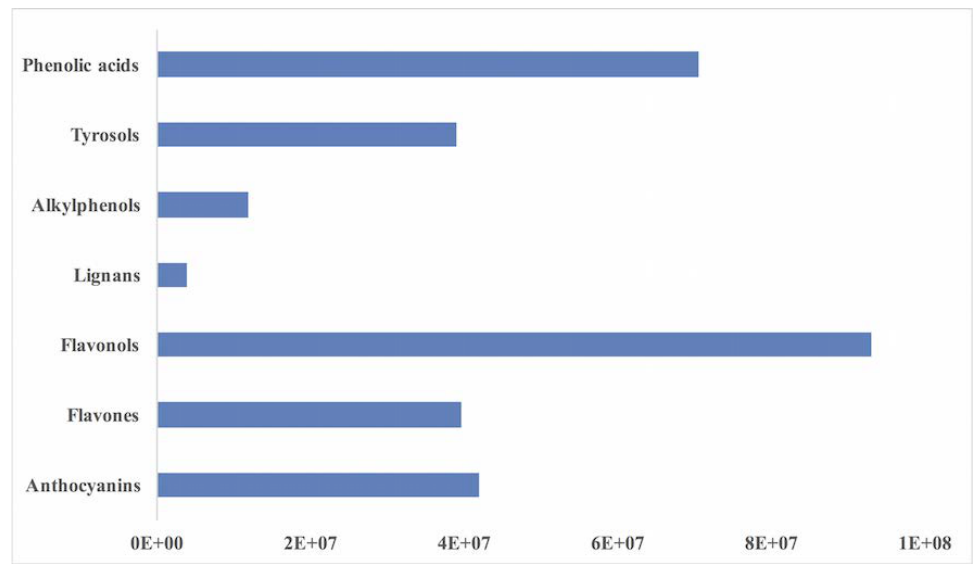
Figure 1. Abundance of different chemical classes of polyphenols in Ficodindia di San Cono PDO cladodes analysed (cumulative intensities as gained from UHPLC-ESI-QTOF-MS profiling).